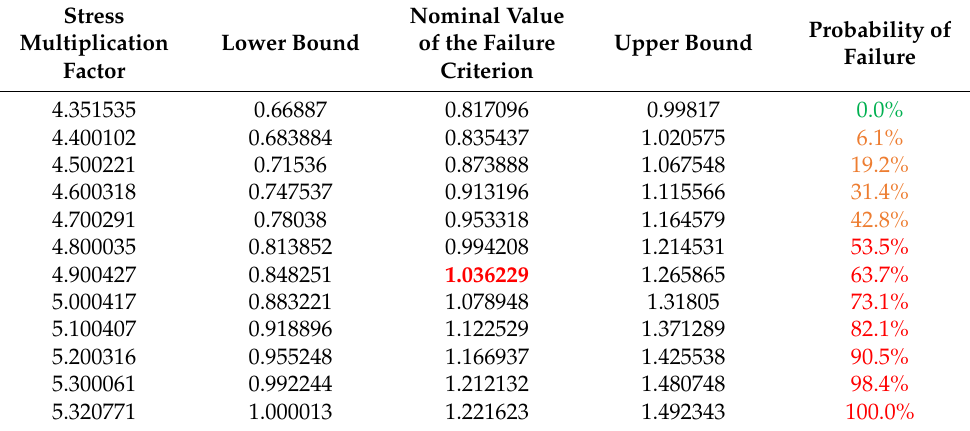
Table 11. Variation in the interval parameters and the probability of failure regarding the stress multiplication factor for the MTF. The bold number in the 3rd column corresponds to the first value of the failure criterion above 1.0 (failure) and the coloring of the values in the last column correspond to different intensity ranges of the probability of failure; the intensity increases from green to dark red. Stress Nominal Value Probability of Multiplication Lower Bound of the Failure Upper Bound Failure Factor Criterion 4.351535 0.66887 0.817096 0.99817 0.0% 4.400102 0.683884 0.835437 1.020575 6.1%